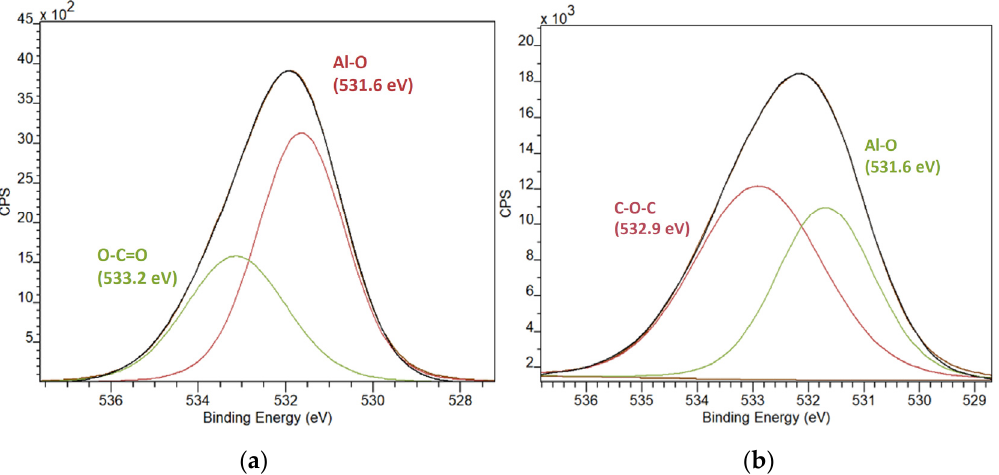
Figure 10. Comparison of high-resolution O 1s spectra of: ( a ) as-deposited AlN sample; ( b ) annealed AlN sample.